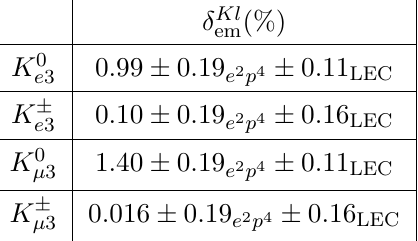
Table 1 . (cid:14) Kl calculated in ChPT em